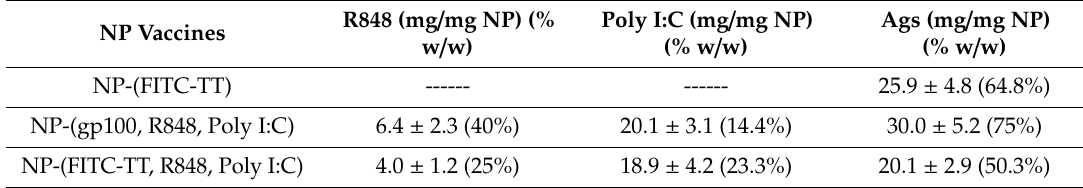
Table 1. Determination of loading e ffi ciency of Ag and TLR-Ls inside of NP vaccines. The e ffi ciency of loading NP vaccines harbouring gp100:272–300 long peptide or FITC-TT peptide and TLR-Ls (R848 and Poly I:C) were determined by RP-HPLC and was also determined by nanodrop system. NP